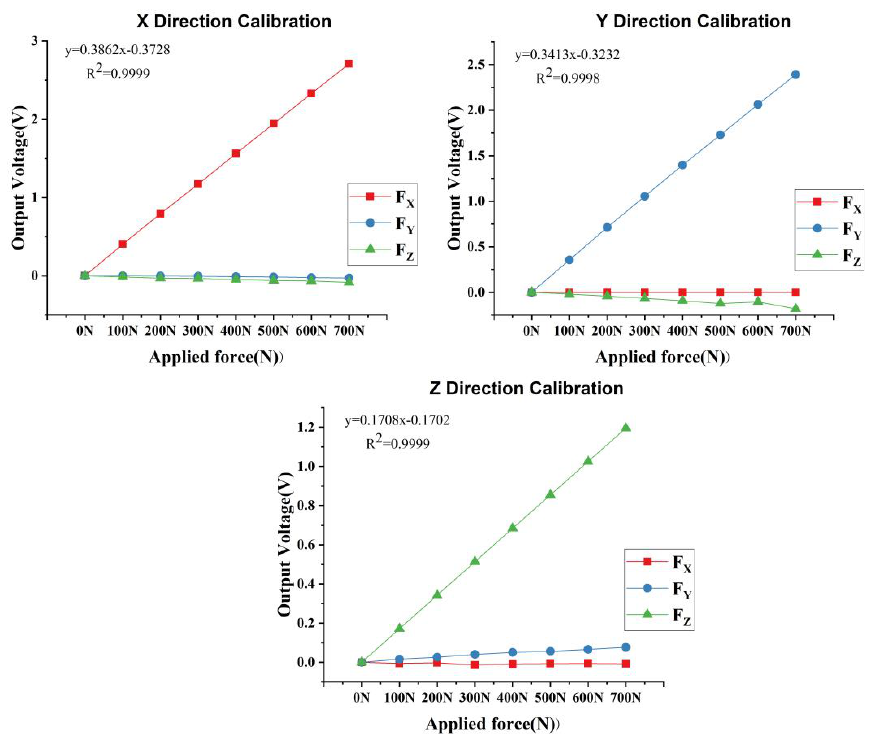
Figure 5. Three-direction calibration results.